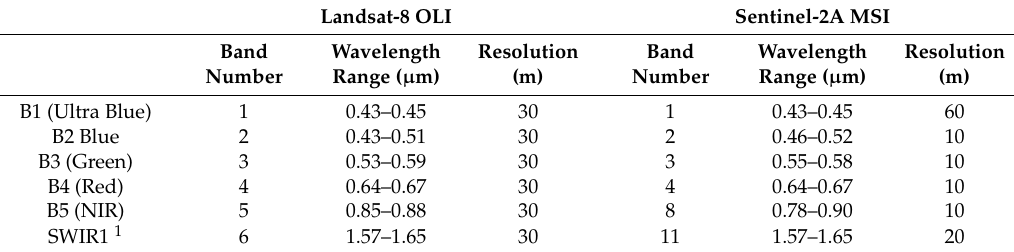
Table 1. Corresponding band characteristics of Landsat-8 Operational Land Imager (OLI) and Sentinel-2A Multispectral Instrument (MSI) sensors.